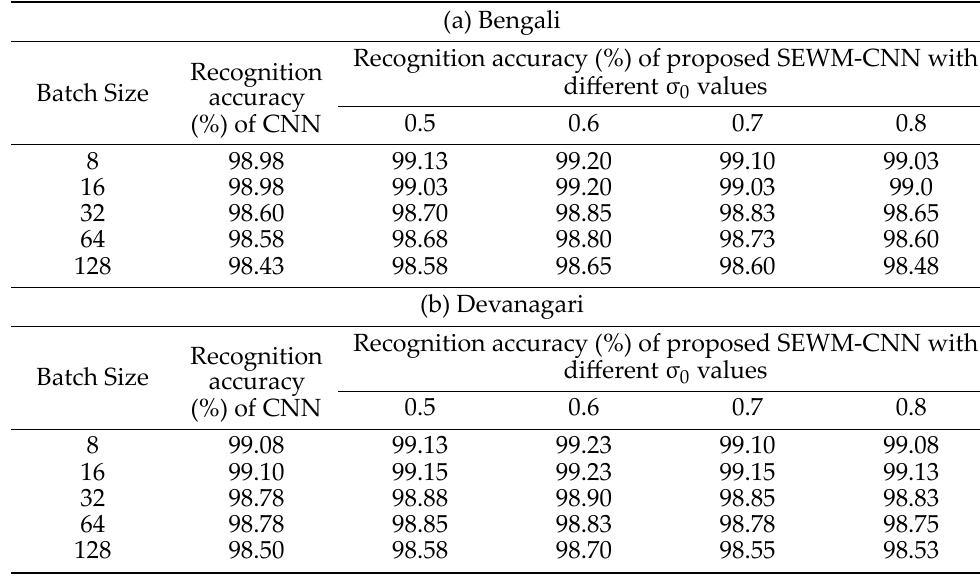
Table 2. Test set recognition accuracy of CNN and proposed SEWM‑CNN with different threshold values for different batch